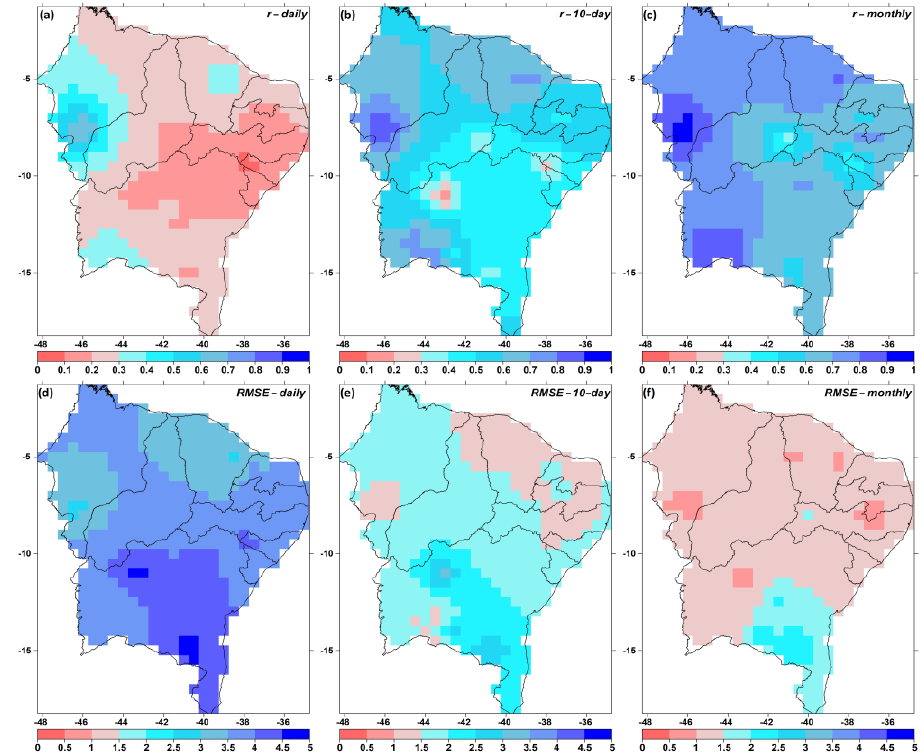
Figure 9. Correlation maps for insolation between imputed and observed data on the daily ( a ), 10-day ( b ) and monthly ( c ) timescales; and RMSE (h) on the daily ( d ), 10-day ( e ) and monthly ( f )